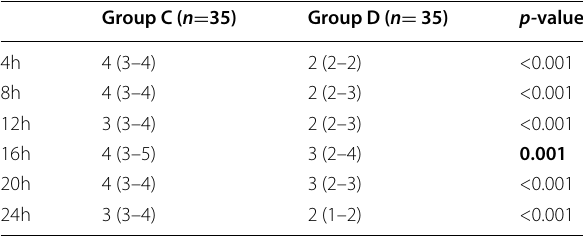
Data are presented as median (IQR) P value < 0.05 is considered statistically